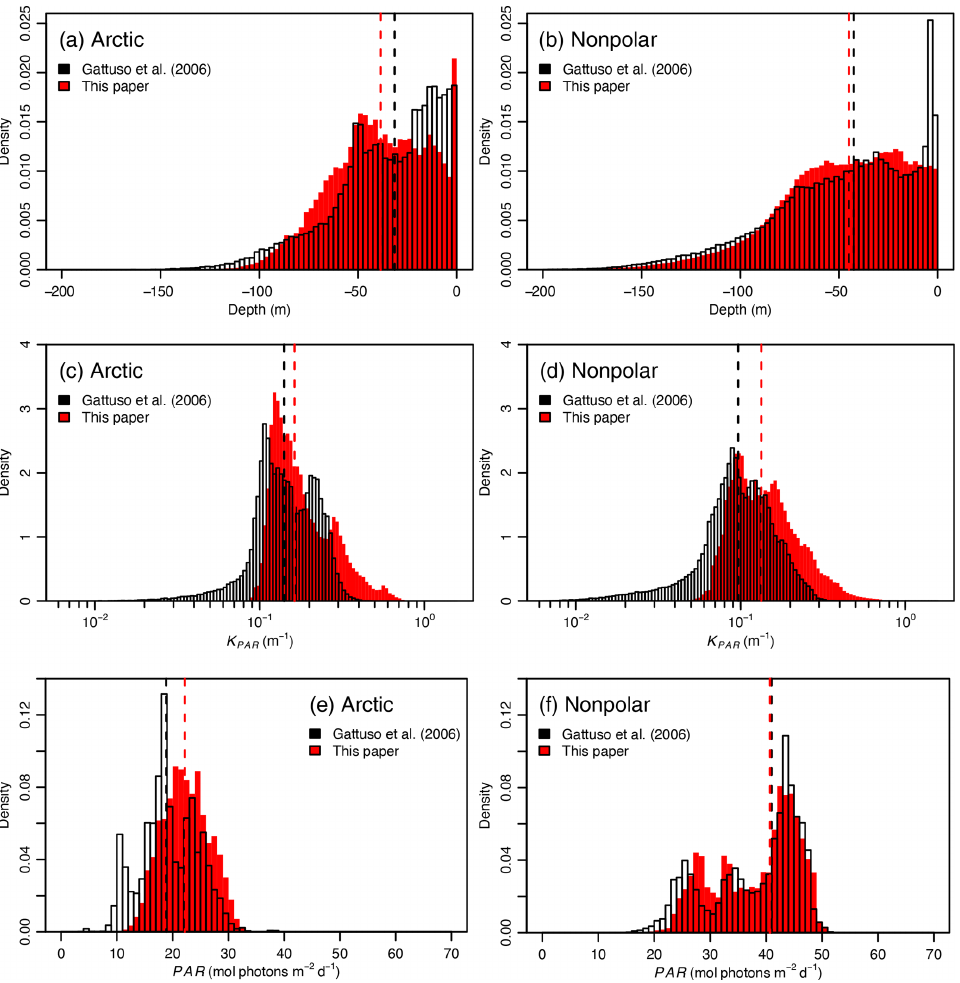
Figure 4. Distribution of depth, K PAR , and PAR in the present study and in Gattuso et al. (2006). The dashed vertical lines represent the median values in the 2006 (black) and present (red) studies.